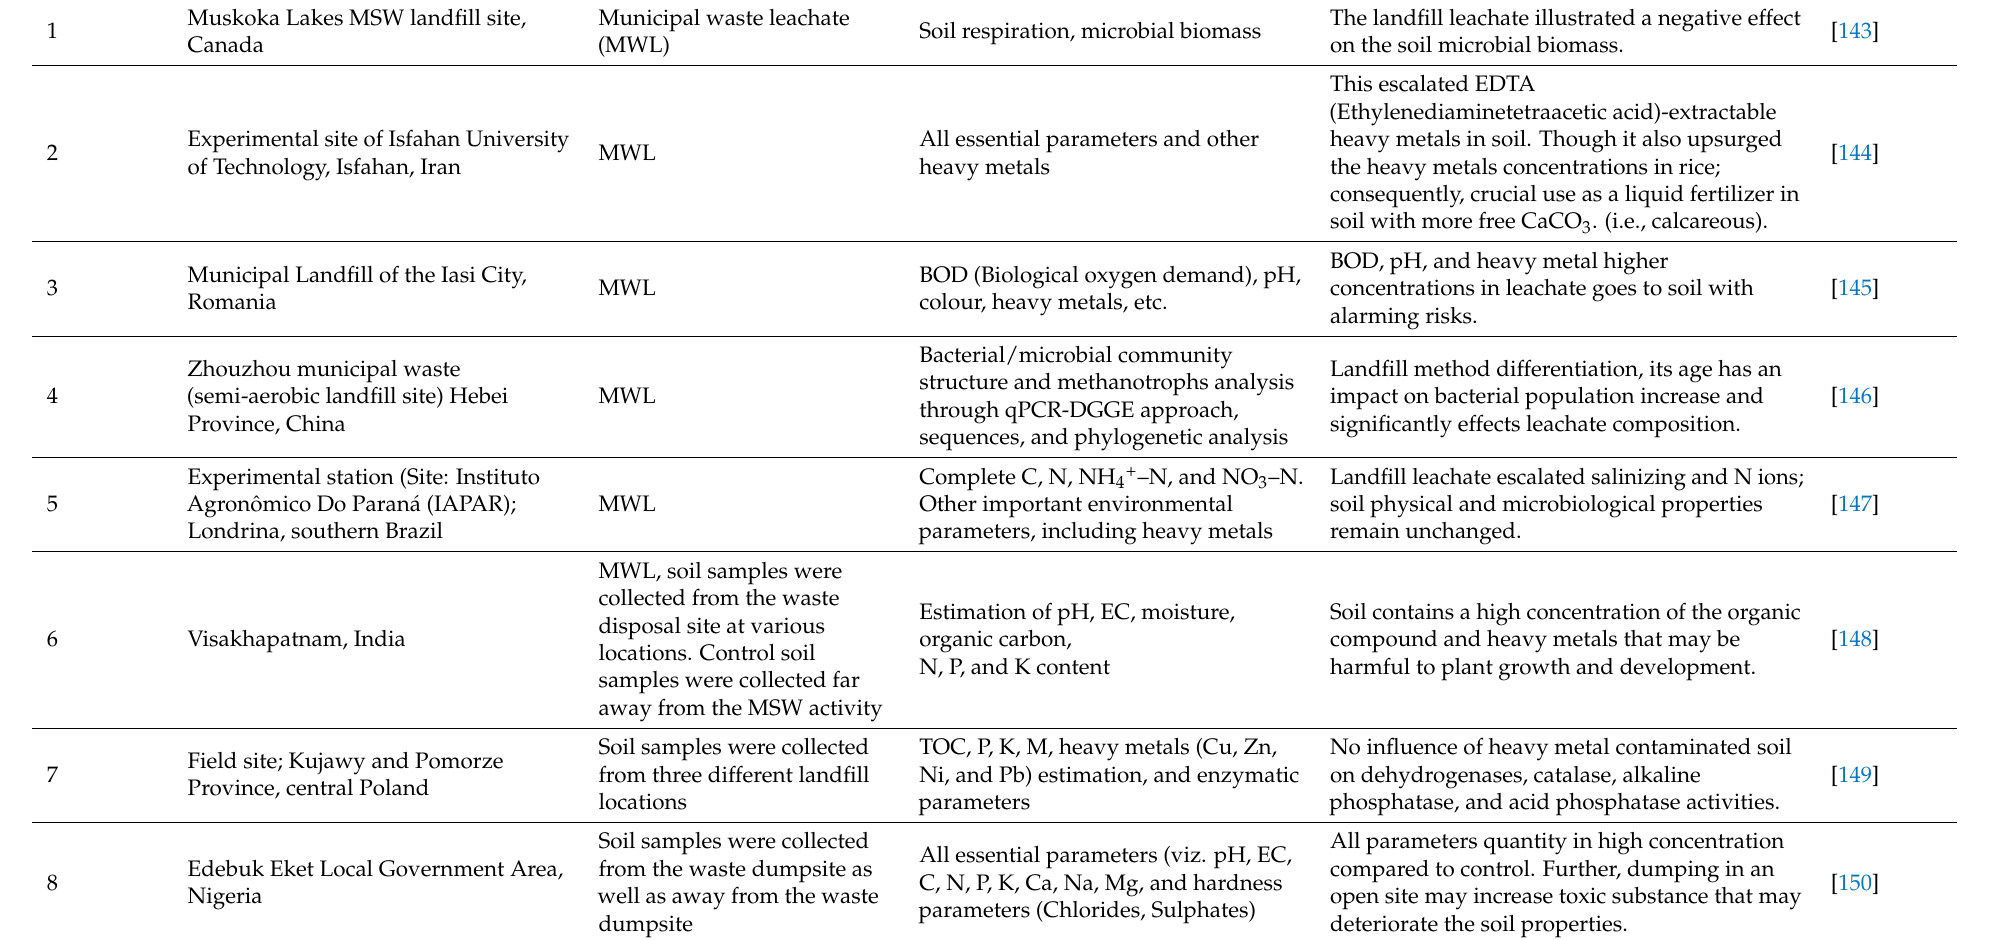
Table 3. The impact of MSW landfill leachate on the soil physicochemical and microbiological properties. Sr.